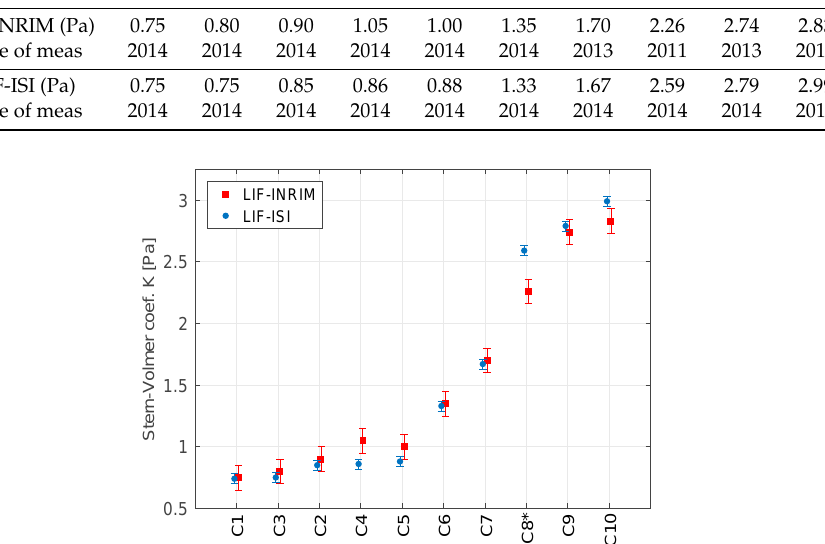
Figure 2. Comparison of the measurements of the original (INRIM) and the upgraded (ISI) LIF setups performed on the same 10 pcs iodine cell set. * The progress in C8’s iodine purity degradation is probably caused by a small leakage on the cell body (release of contaminants).